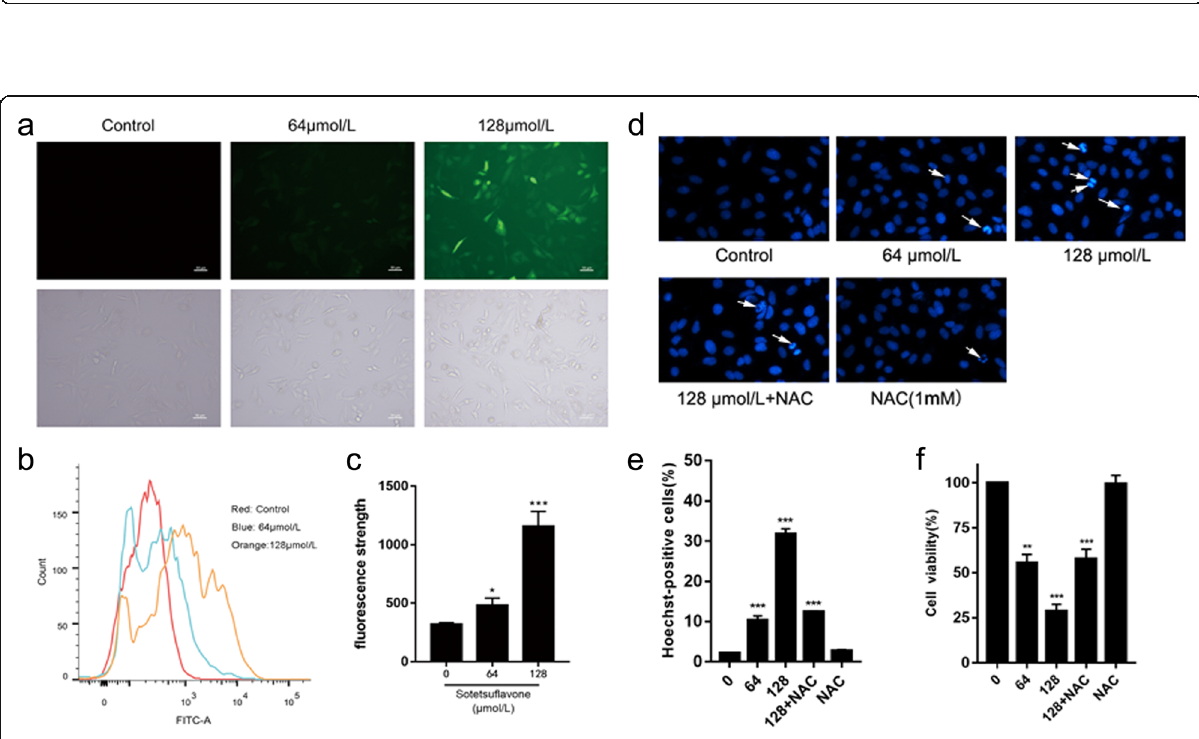
Fig. 3 Effect of sotetsuflavone on cell cycle and apoptosis rate in A549 cells. a Cell cycle arrest in A549 cells with sotetsuflavone through Flow cytometry. b Hoechst 33,258 staining: further evidence of drug induced apoptosis, with the increase of concentration correlated with an increase in the number of dark stained cells, indicating increased, consistent with the flow pattern of Fig. 2c. c The table shows the effect of sotetsuflavone on cell cycle arrest in A549 cells. The results from three independent experiments were expressed as mean±SD compared with the control group, *** P